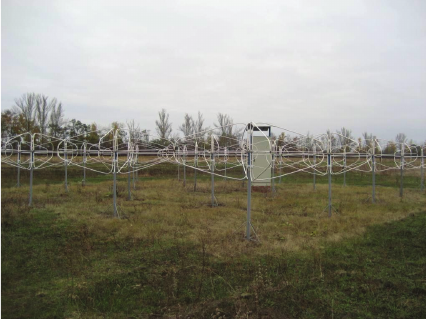
Figure 1: Active antenna array of 5 × 5 elements as a basic part of the GURT radio telescope.